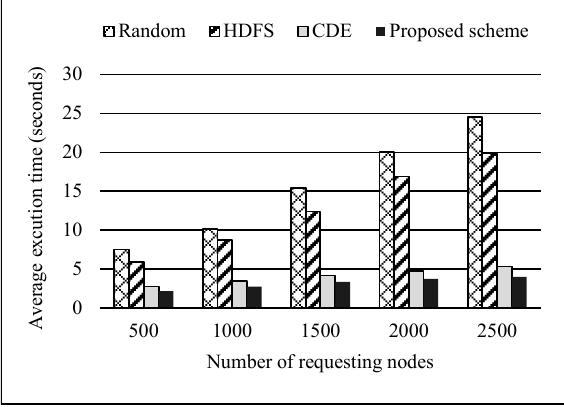
Fig. 10. The comparison of average execution times.